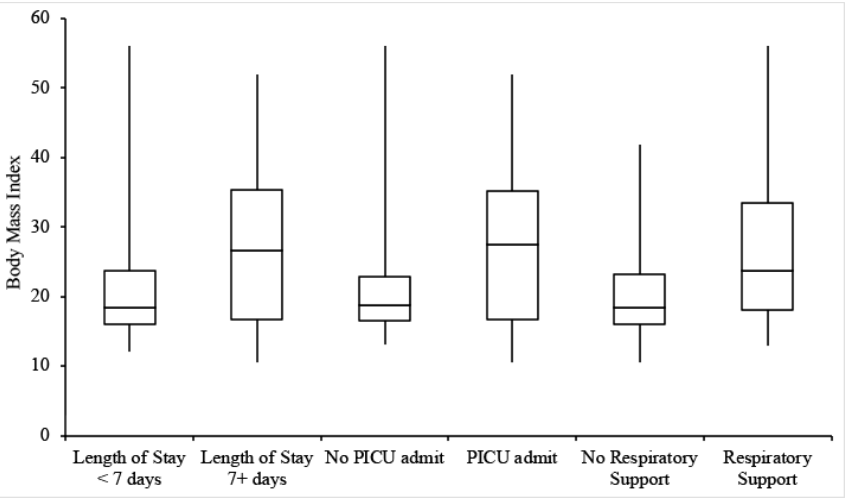
Figure 2. Box-and-whisker plots for the BMIs of patients experiencing each outcome of interest.